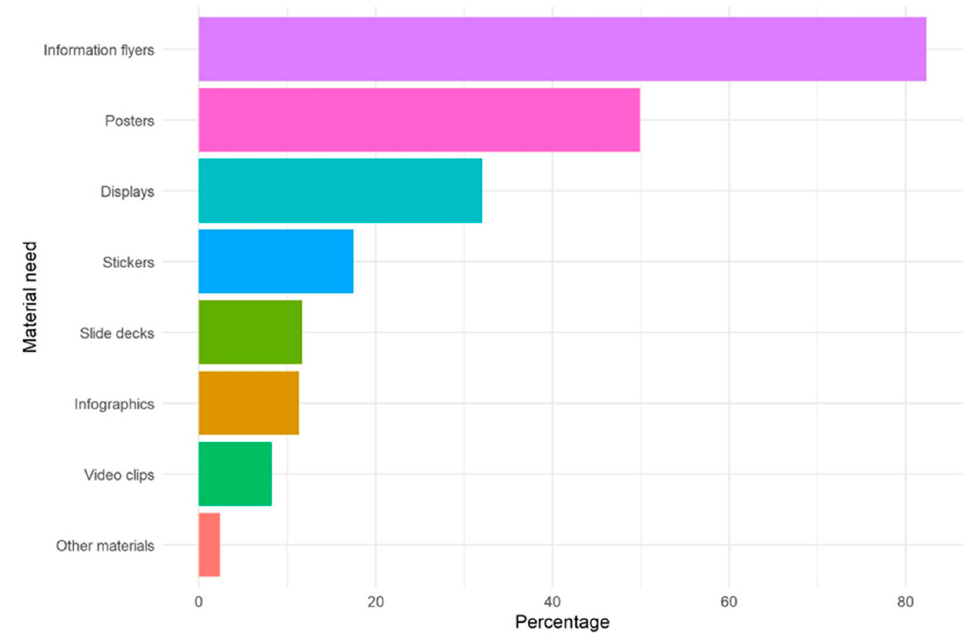
Figure 1. Type of information materials and educational media on TBE vaccination and tick-borne diseases needed, as indicated by primary care physicians with a need (N = 549), TBD-Prev survey, Germany, 24 May–30 September 2022. There were in total 558 physicians who indicated a need for information materials and educational media, but 9 did not complete the question about which kind of materials.